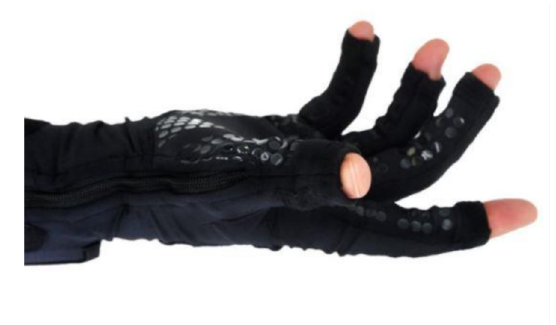
Figure 29. StretchSense